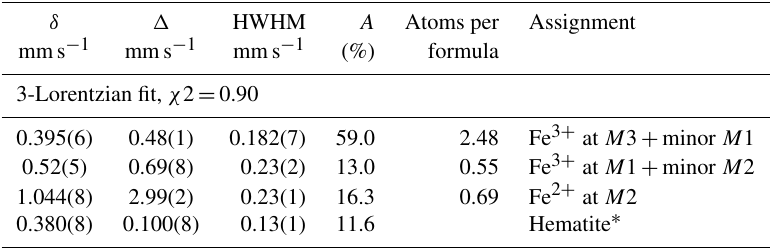
Table 1. Mössbauer parameters for manganrockbridgeite and hematite, isomer shift δ , quadrupole splitting (cid:49) , half width at half maximum (HWHM), and relative areas of the doublets and sextet, A .